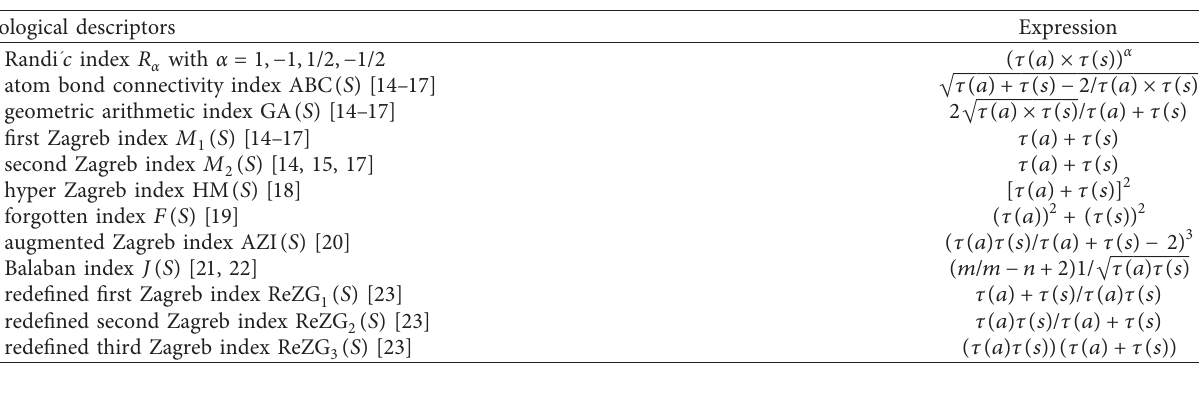
Table 1: Topological descriptors.